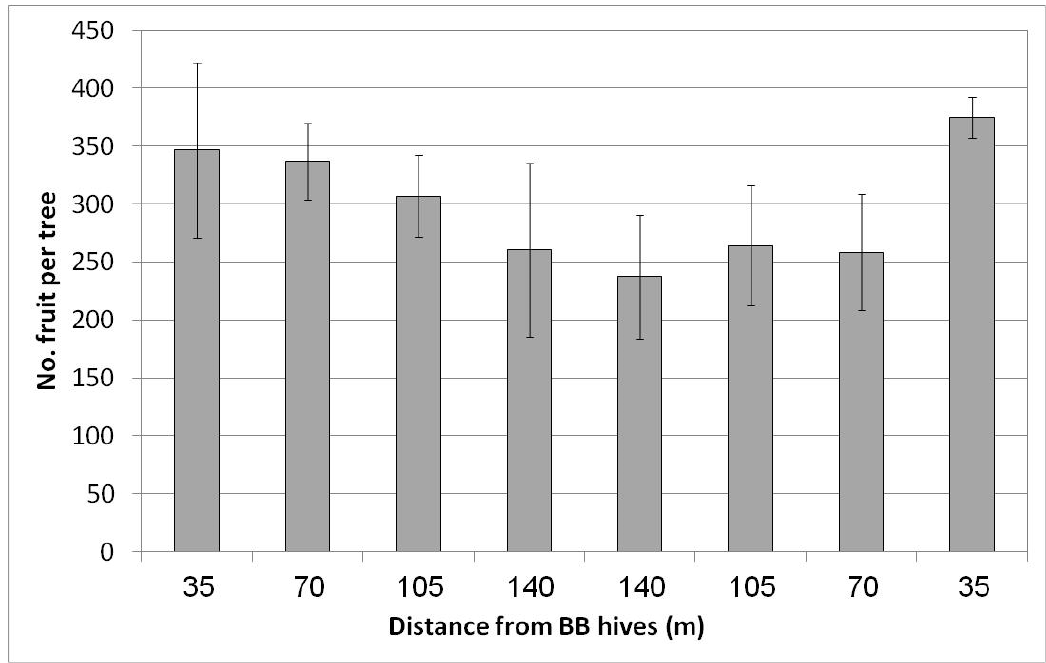
Figure 7. Effect of adding bumblebee (BB) hives (April 2019) to both sides of the orchard on the number of fruit per tree in February 2020 at all distances from the BB hives, Regba, 2019/20. Data are the means of five ‘Hass’ trees at each distance ± SE.